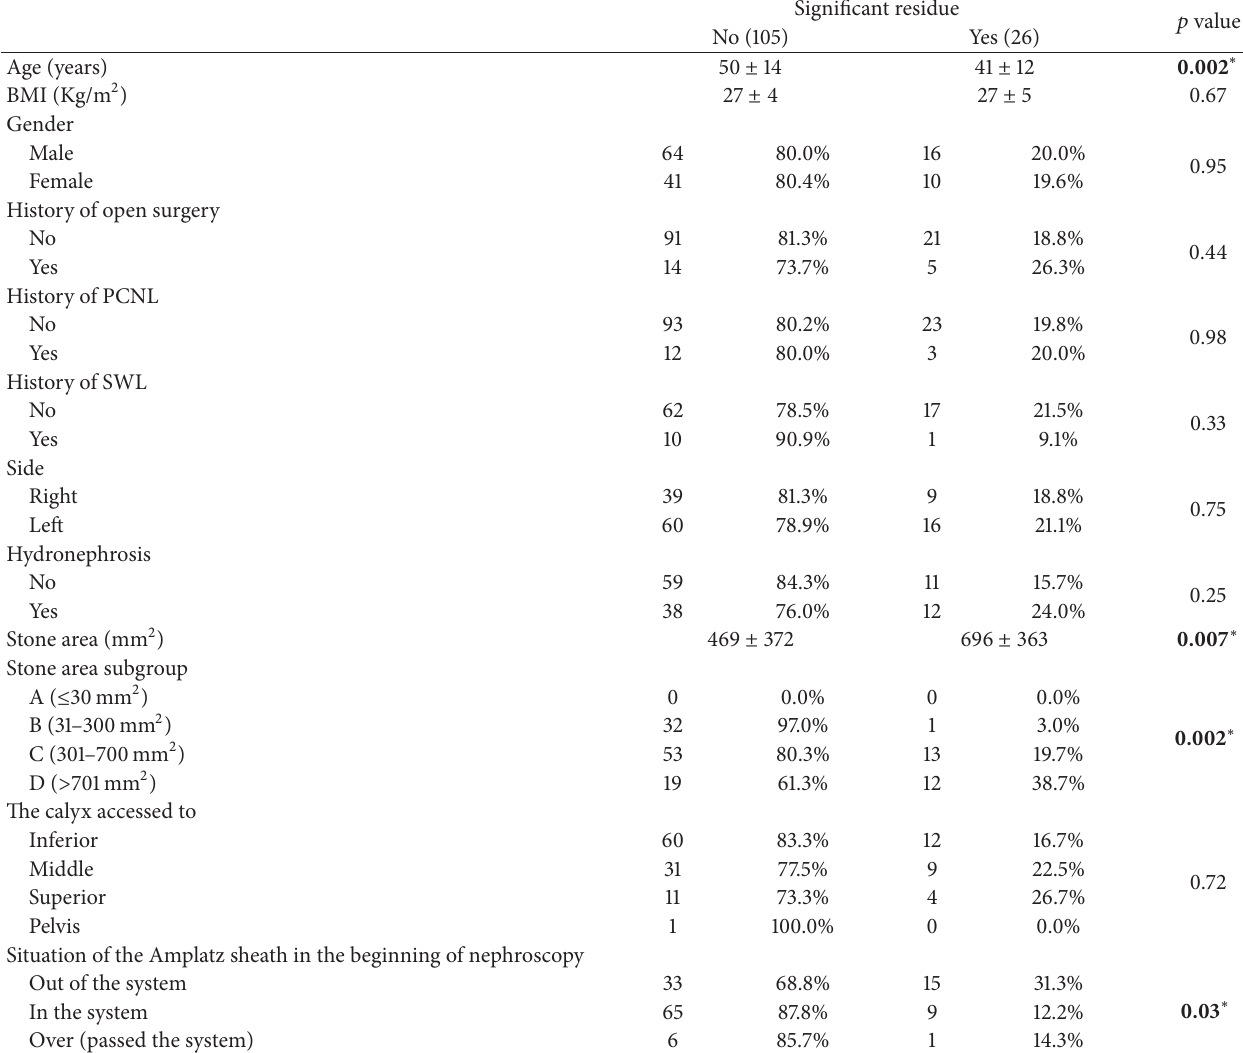
Table 2: Data of patients regarding their residual stone status in early postoperative imaging, excluding eight failed